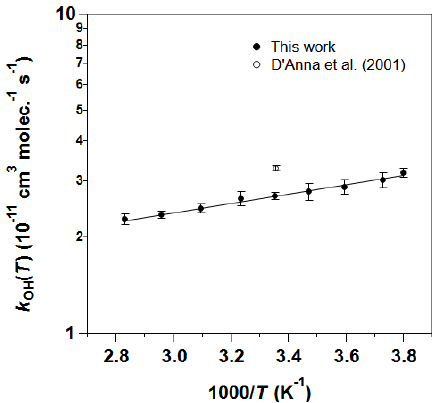
Figure 6. Chromatograms obtained for a 2MB and Cl 2 mixture before irradiation (a) and after 60min of irradiation (b)